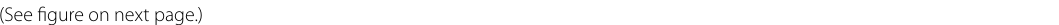
(See figure on next page.) Fig. 5 circ_0007059 targeted miR‑1278 and miR‑1278, in turn, targeted SHP‑1. A Graphical illustration of the conserved circ_0007059 binding motifs in the 3 ′ ‑UTR of SHP‑1 for miR‑1278 and miR‑1278‑binding motifs. B , C a luciferase reporter assay was used to measure luciferase activity, including wild‑type or mutated (MU) copies of human circ_0007059 and SHP‑1 after transfection an miR‑1278 mimic in HEK293 cells. Luciferase activity was normalized to that of Renilla luciferase (biological replicates, 1; technical replicates, 3; repeat time, 3). D , E the expression of miR‑1278 and SHP‑1 mRNA in renal biopsy samples from patients with LN (n 30) and adjacent normal tissue samples (n 10) as measured by RT‑qPCR = = are shown. RMC and HEK293 cells were transfected with a circ_0007059‑overexpressing vector or NC vector for 24 h, followed by treatment with 1000 units/mL IFN for 24 h (biological replicates, as indicated; technical replicates, 3; repeat time, 3). F , G miR‑1278 levels in RMCs and HEK293 cells were measured by RT‑qPCR (biological replicates, 1; technical replicates, 3; repeat time, 3). H , I RT‑qPCR and J , K WB was performed to detect SHP‑1, STAT3, and phosphorylated STAT3 levels in RMCs and HEK293 cells (biological replicates, 1; technical replicates, 3; repeat time, 3). Results are expressed as the